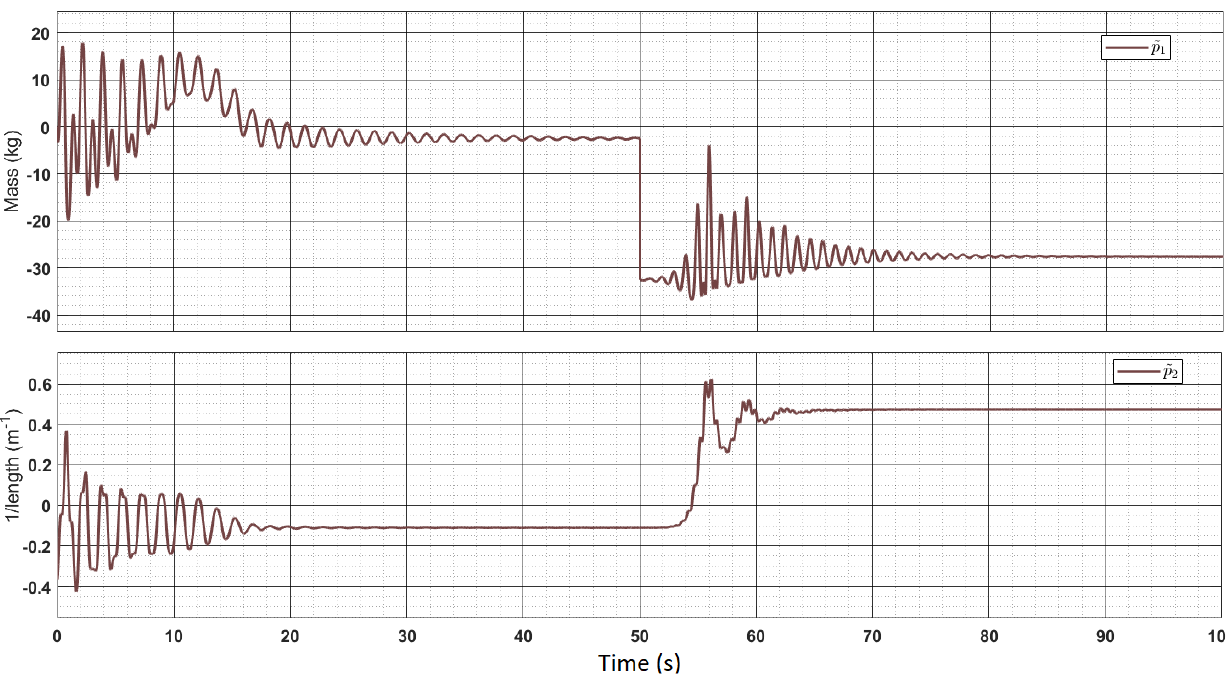
Figure 22. Parameter errors.